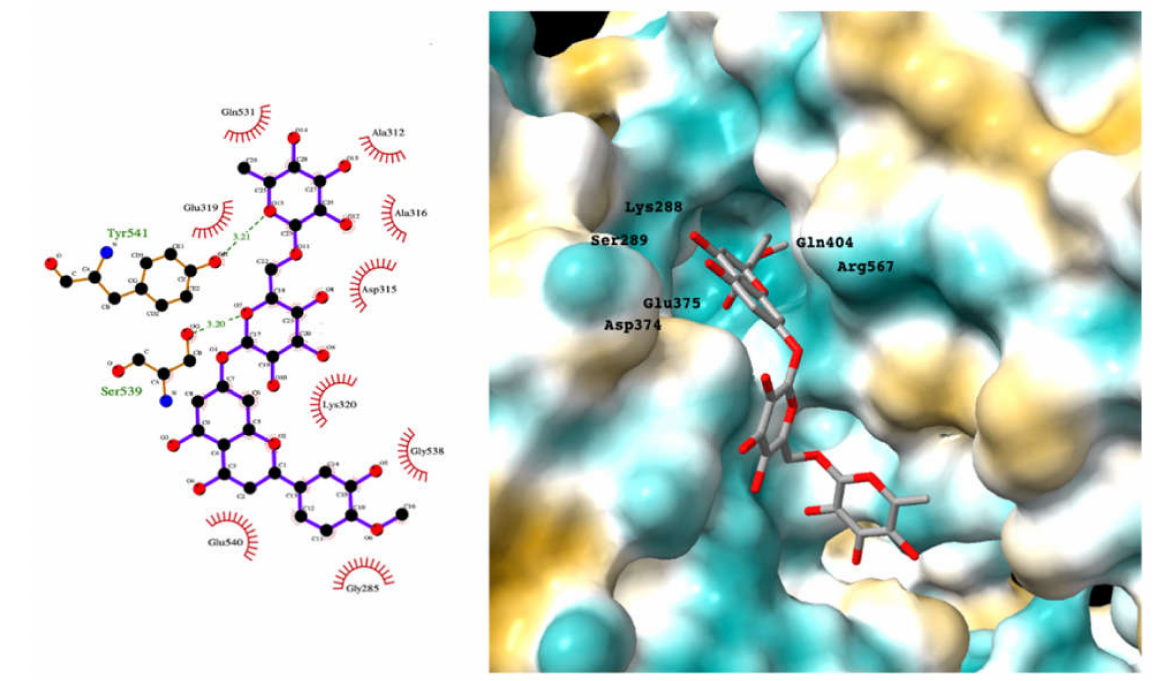
Figure 3. LigPlot ( left ) shows the key active site residues interacting with hesperidin. The molecular model ( right ) shows the binding of hesperidin to the active site cleft of the helicase. The molecular surface denotes hydrophobicity of the pockets (blue hydrophilic, yellow/brown hydrophobic). Positions of key binding site residues are labeled.